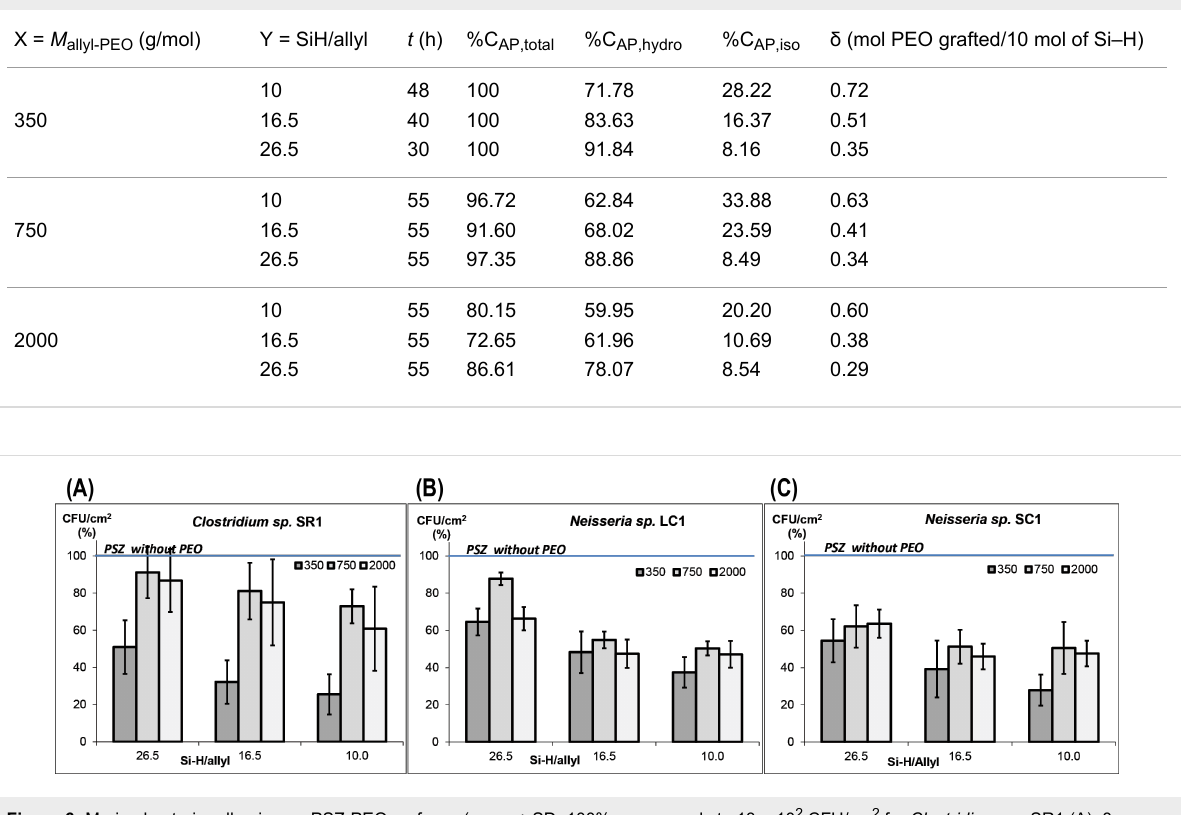
Table 1: Conversion of allyl-PEO and density of the grafted PEO chains onto PSZ calculated from 1 H NMR spectra. X = M allyl-PEO (g/mol)